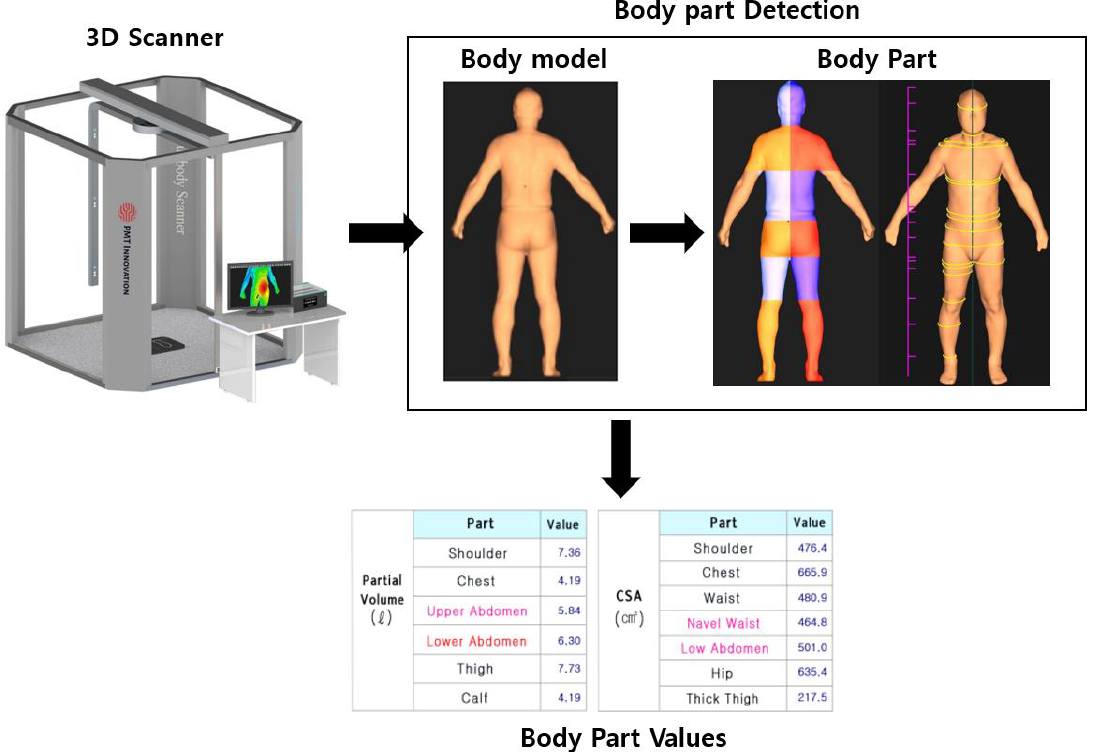
Figure 1. Three-dimensional values derived from the body scan process .